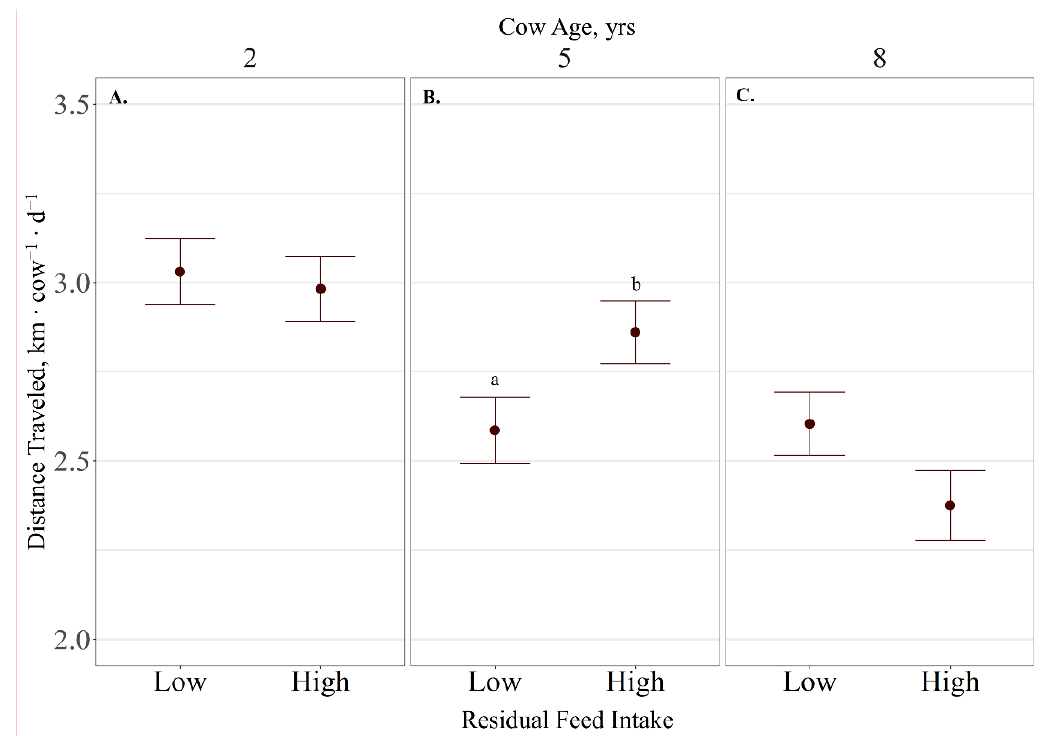
Figure 5. Influence of residual feed intake × cow age ( A – C ; p = 0.02) on average distance traveled expressed as km cow − 1 · d − 1 ± SE) by cattle grazing dormant northern mixed-grass prairie in 2018/2019 and 2019/2020 at the Northern Agriculture Research Center’s Thackeray Ranch, Havre, MT, USA. Means lacking common letters (a, b) differ ( p < 0.05). Herd-level grazing resource utilization for cattle on dormant rangeland forage was not impacted by aspect ( 𝛽̅(cid:4632) North = 0.02 ± 0.01; 𝛽̅(cid:4632) South = − 0.01 ± 0.01; 𝛽̅(cid:4632) East = − 0.02 ± 0.02; 𝛽̅(cid:4632) West = − 0.01 ± 0.02), elevation ( 𝛽̅(cid:4632) = 0.07 ± 0.37), distance to supplement ( 𝛽̅(cid:4632) = − 0.37 ± 0.51), distance to water ( 𝛽̅(cid:4632) = 0.04 ± 0.44), or terrain ruggedness ( 𝛽̅(cid:4632) = − 0.06 ± 0.03; Figure